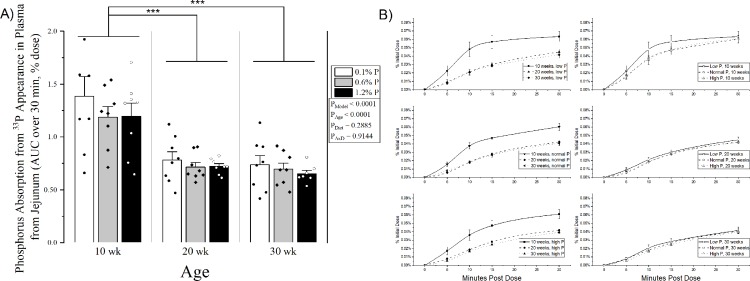
A) Jejunal phosphorus absorption determined by appearance of
33P in plasma over 30 minutes (AUC). Means and standard error bars are shown for each group. Low phosphorus diet (0.1%) is shown in white bars and black dots; normal phosphorus diet (0.6%) is shown in grey with black diamonds; and high phosphorus diet (1.2%) is shown in black with white circles. ANOVA p-values for the overall model (PModel), main effect of age (PAge), main effect of diet (PDiet), and interaction of age and diet (PAxD) are shown. B) Jejunal phosphorus absorption determined by appearance of
33P in plasma over 30 minutes (time series). Each diet group (left) and each age group are compared (right). Results at 30 minutes were similar to AUC. Absorption was calculated as percent of total 33P activity in the initial dose. There was a main effect for age where 10 week old rats had higher phosphorus absorption compared to both 20 and 30 week olds, but there was no significant effect of dietary phosphorus intake level and no significant age x diet interaction. *** p < 0.0001. n = 1 excluded for missing last 2 timepoints.